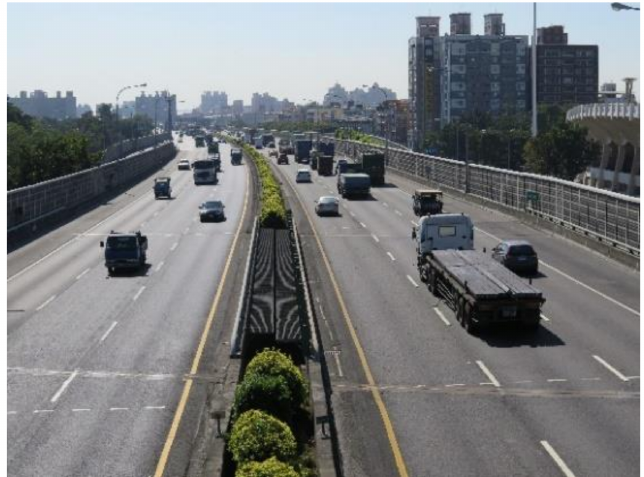
Figure 5. Sample image of the video taken on National Freeway